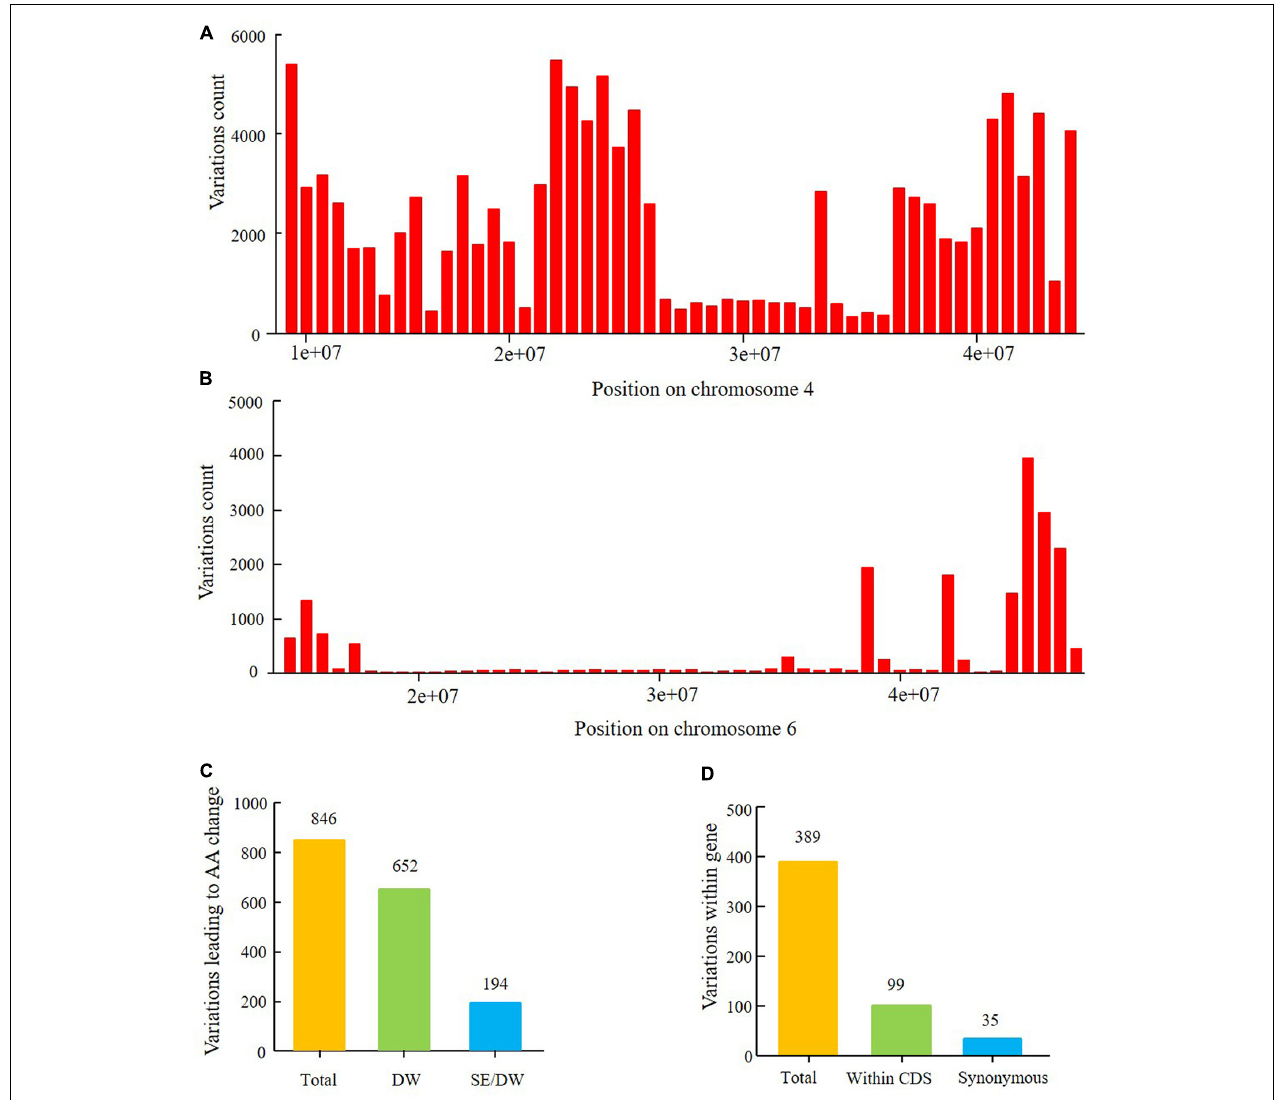
FIGURE 10 | Nucleotide sequence polymorphism of parents of the two RIL populations within the intervals of two major QTLs. (A) Polymorphism SNP number between parents Dongnong 50 and Williams 82 within QTL interval from 9,226,038 to 44,284,689 on chromosome 4. (B) Polymorphism SNPs and Indels between Suinong 14 and Enrei within the QTL interval from 14,777,428 to 47,231,089 on chromosome 6. (C) Polymorphism SNPs and Indels leading to amino acids (AA) change in the 1.5-LOD drop QTL interval from 13,212,370 to 43,843,500 on chromosome 4 between Dongnong 50 and Williams 82. Total: all SNPs and Indels; SE/DW: the same polymorphism SNPs and Indels between four parents of the two RIL populations which were with the same variation position and variation type; DW: SNPs and Indels uniquely detected between Dongnong 50 and Williams 82. (D) Polymorphism SNPs and Indels within gene (5 (cid:48) UTR, CDS, 3 (cid:48) UTR) in the 1.5-LOD drop QTL interval from 15,741,239 to 42,126,497 of chromosome 6 between parents Suinong 14 and Enrei. Total: all SNPs and Indels; Within CDS: SNPs and Indels number within the CDS region of one gene; Synonymous: variations that resulted in no change in amino